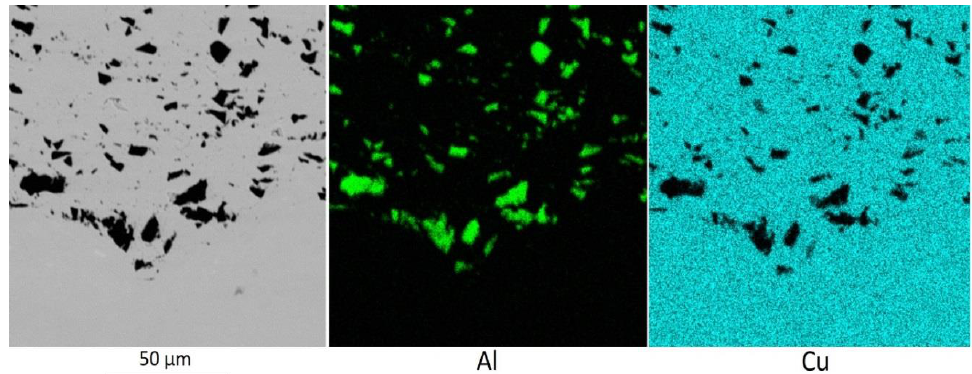
Figure 4. A group of alumina particles embedded locally in the substrate surface for the cold-sprayed Cu-60% Al 2 O 3 coating without preprocessing and distribution maps of elements.